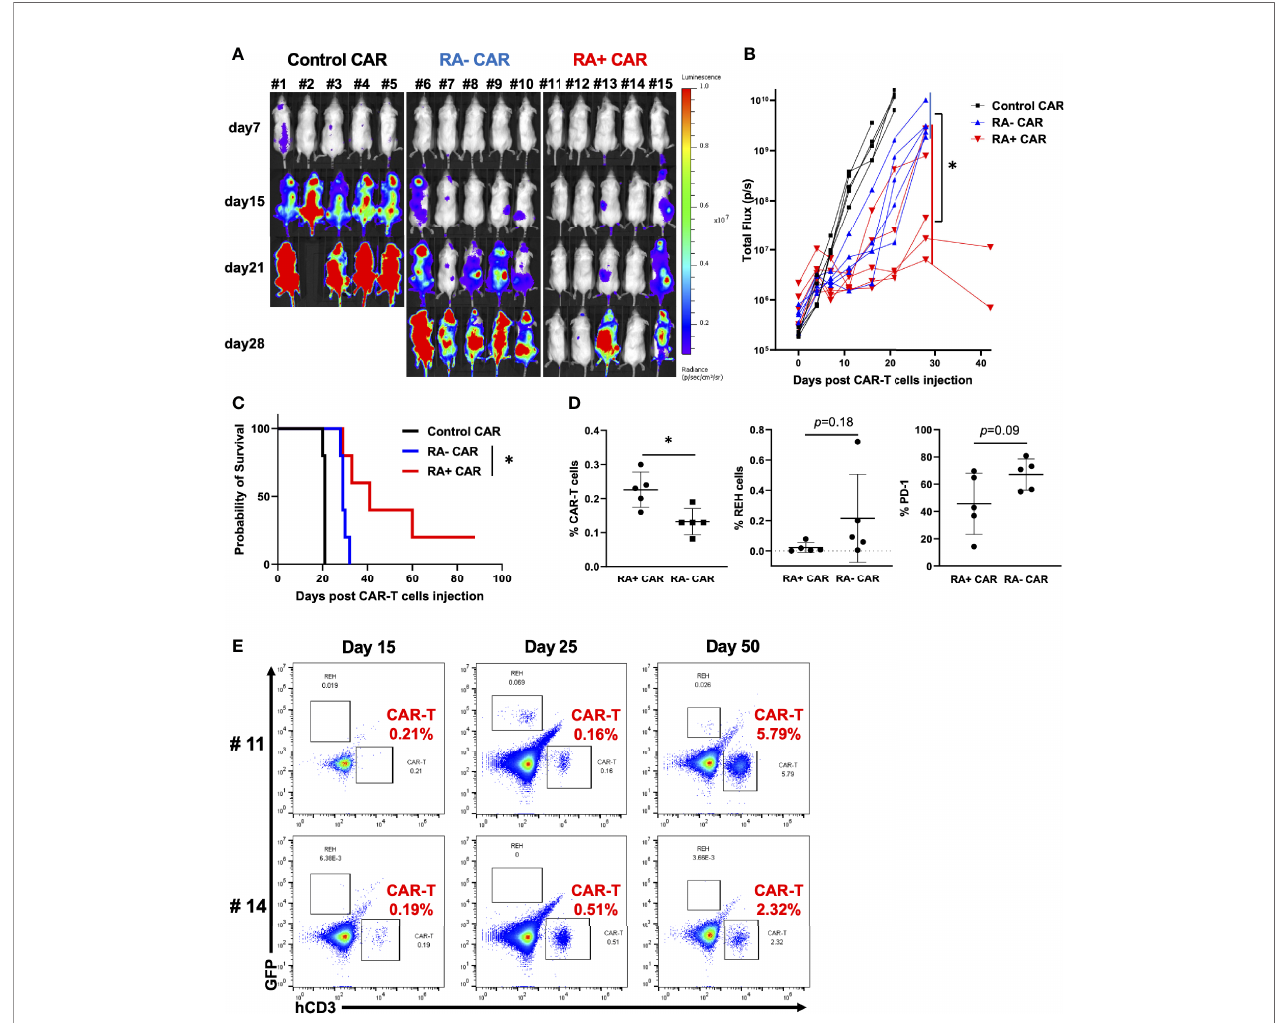
FIGURE 3 | CD45RA + chimeric antigen receptor (CAR)-T cells achieved prolonged tumor control with long-term expansion of CAR-T cells in vivo. We infused 5 × 10 5 REH-FFLuc cells into NSG mice via the tail vein. Six days later, 1 × 10 5 RA + CAR-T, RA − CAR-T, or control (EPHB4) CAR-T positive cells were infused into the tail vein of each mouse. (A) Bioluminescence images of groups of fi ve NSG mice after intravenous CAR-T cell infusion. (B) The tumor volumes of each mouse measured as total fl ux (p/s) are shown. The CD45RA + CAR-T group showed a statistically signi fi cant tumor reduction, measured as the mean total fl ux at day 28, compared with the CD45RA − CAR-T group. (C) The Kaplan – Meier plot of overall survival (each group, n = 5). The CD45RA + CAR-T group achieved prolonged tumor control compared with the CD45RA − CAR-T group. Log-rank test: *P < 0.05. (D) On day 15 after CAR-T cell injection, bone marrow analysis showed CAR-T cells (left), REH cells (middle), and PD-1 expression on CAR-T cells (right) by fl ow cytometry. (E) In most long-lived mice infused with RA + CAR-T cells, CAR-T cells, and REH cells in the bone marrow of mice on days 15, 25, and 50. Representative dot plot data are shown. All data are presented as mean ± standard deviation. *P <